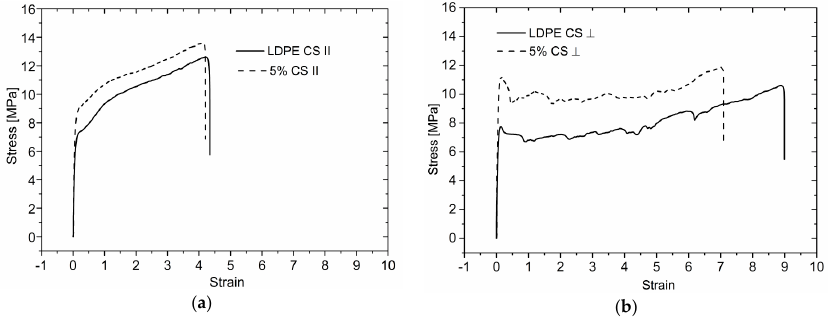
Table 3. Basic characteristics of the low density polyethylene and GnP nanoplatelets as a filler.